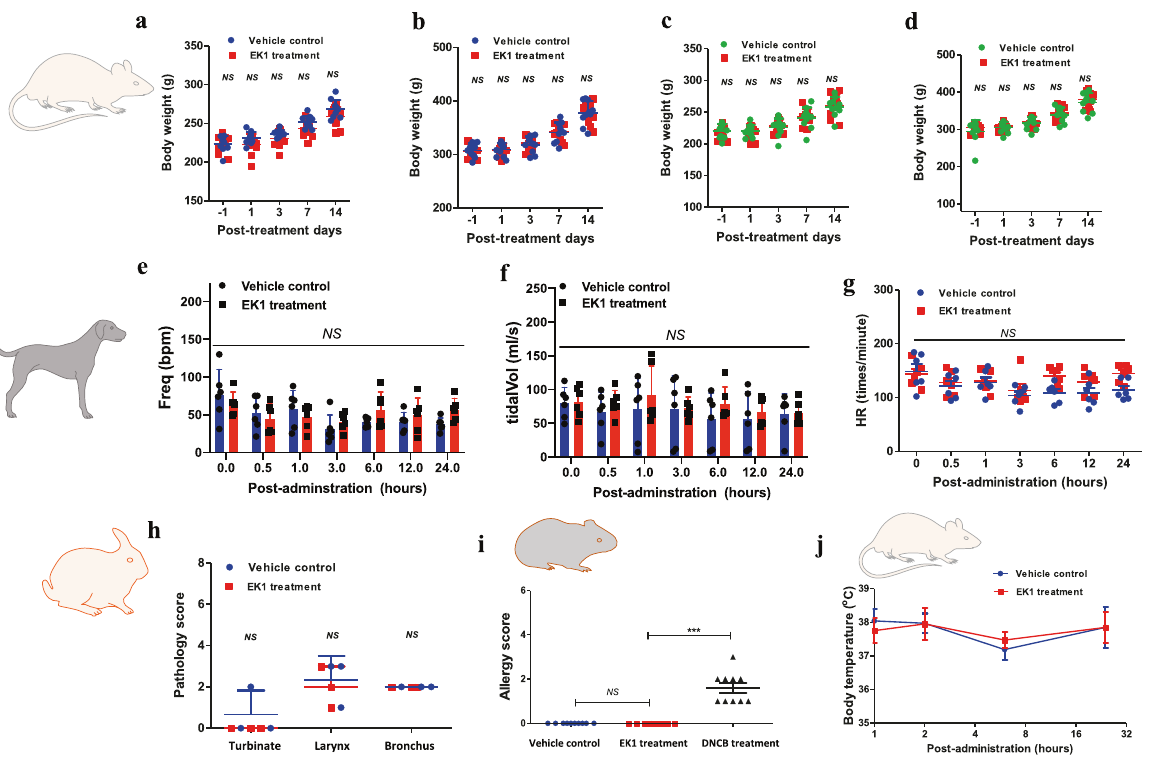
Fig. 6 Preclinical safety of EK1 peptide in a pharmaceutical formulation. a – d In vivo safety of EK1 peptide on SD rats. The body weight of female ( a ) and male ( b ) SD rats treated by EK1 peptide (75 mg/kg) through the aerosol inhalation route. Body weight of female ( c ) and male ( d ) SD rats treated with EK1 peptide (180 mg/kg) through the tail vein injection route. e – g Effect of EK1 peptide (24 mg/kg) through the aerosol inhalation route on cardiopulmonary function in beagle dog model, including respiratory frequency ( e ), tidal volume ( f ), heart rate, HR ( g ). Those indicators were monitored by the emkaPACK4G animal physiological signal telemetry system. h “ Nasal mucosa irritation test ” of EK1 peptide (0.88 mg/kg) on a rabbit model. Pathogenic score is based on epithelial cell shedding, goblet cell hyperplasia, eosinophilic in fl ammatory cell invasion and mixed in fl ammatory cell invasion. i “ Active skin allergy test ” of EK1 peptide (4.0 mg/kg) on guinea pig model. j Effect of EK1 peptide (18 mg/kg) on the central nervous system. After administration of EK1 peptide through aerosol inhalation, the body temperature changes on SD rat model. *** P < 0.001; “ NS ” indicates no statistical